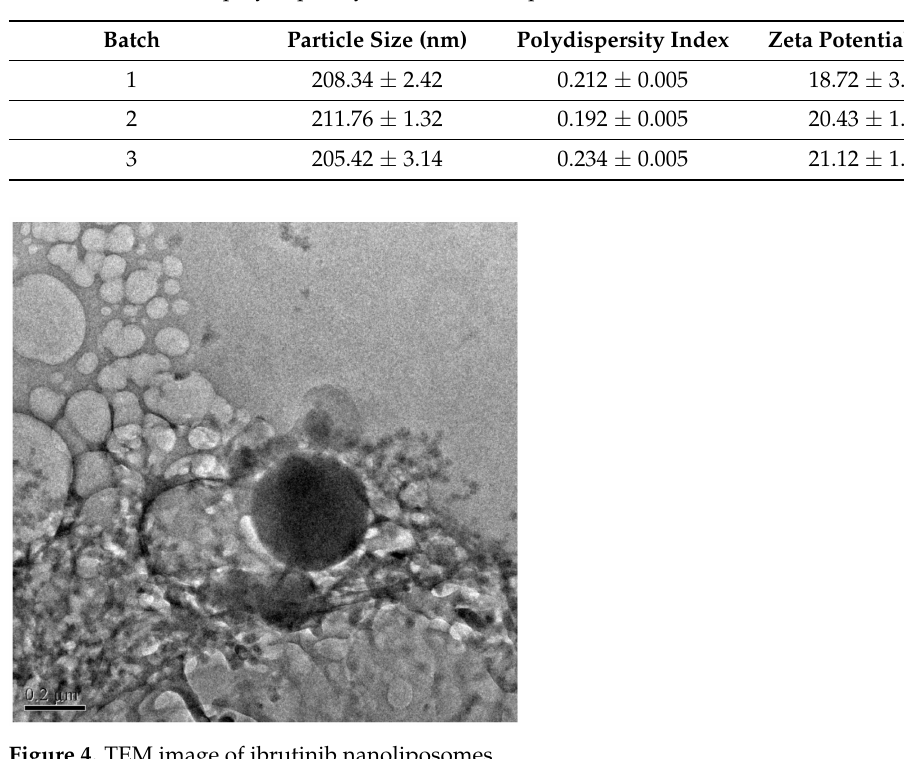
Table 6. Particle size, polydispersity index, and zeta potential values.